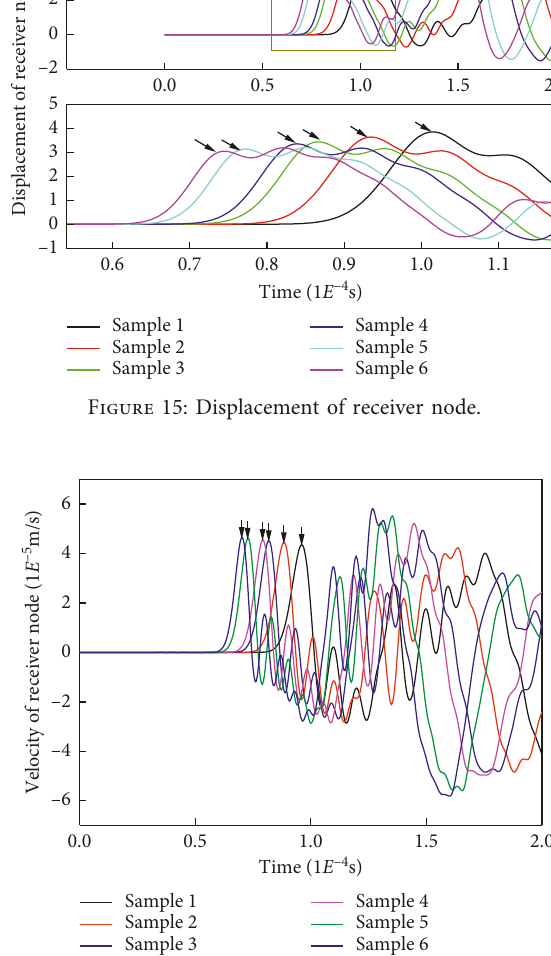
Figure 16: Velocity of receiver node.